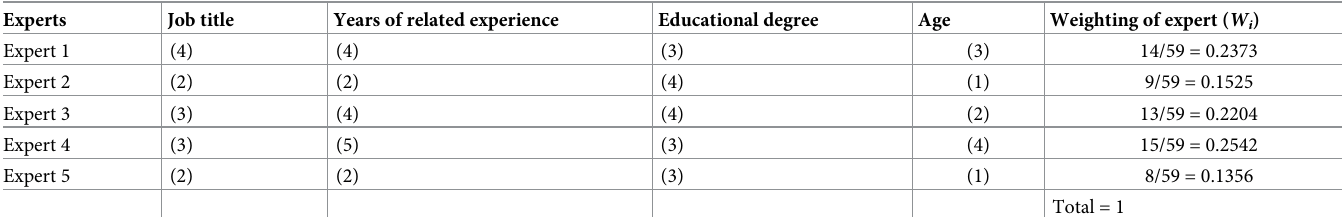
Table 3. Selected expert profiles and their weighting